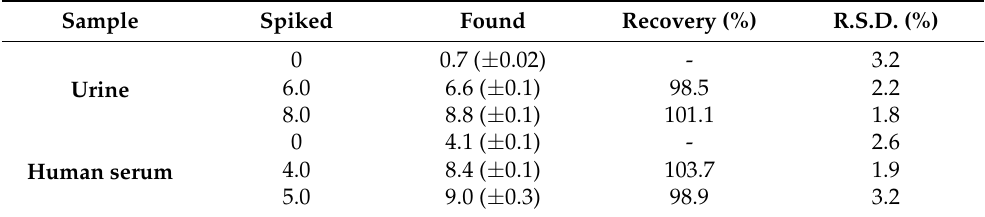
Table 1. Homocysteine detection in human urine and serum matrices ( n = 5 (the measurement of each concentration was repeated five times.)); all concentrations are in µ M.